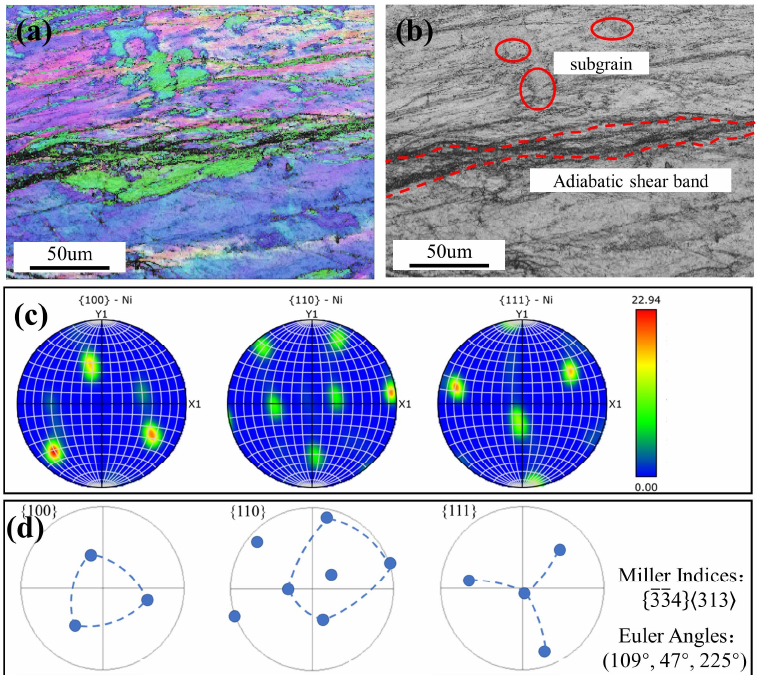
Figure 4. EBSD diagram of cold‑rolled Ni 2 CrFe MEA: ( a ) color‑coded crystallite orientation + grain boundary maps; ( b ) band contrast map; ( c ) polar map of (100), (110) and (111); ( d ) { 334 } <313> stan‑ dard pole figure.